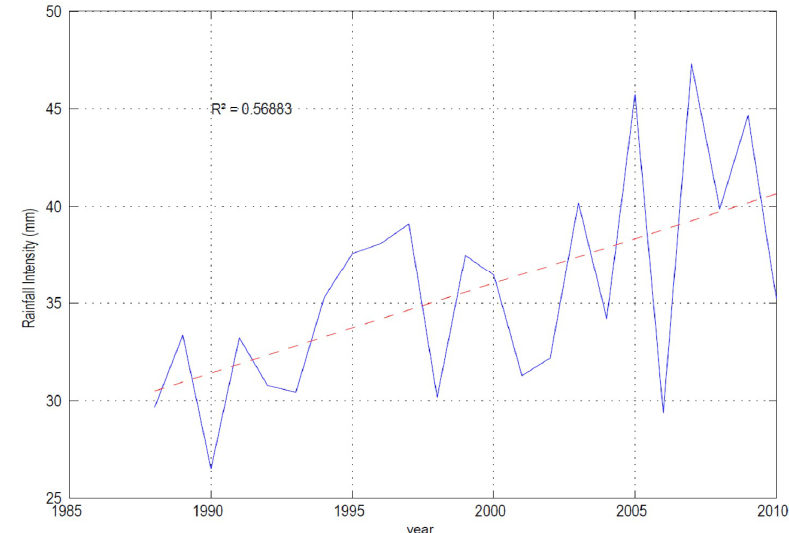
Figure 13. Interannual variation of the daily rainfall maxima from 1988 to 2010 in the Mono river basin at the outlet of Nangbéto.